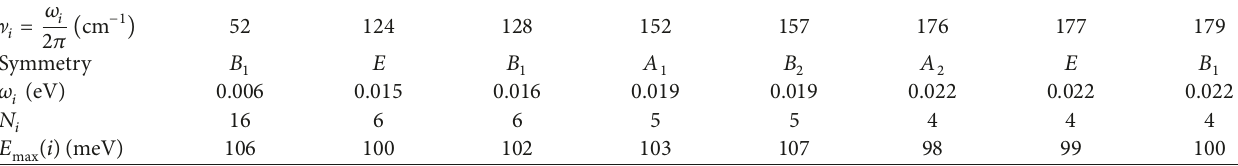
Table 1: The frequency modes below the Debye temperature for 𝛼 -TeO 2 obtained from Table VIII of [60] (for notation see text). 𝜔 𝑖 ( cm −1 ) ] = 𝑖 2𝜋